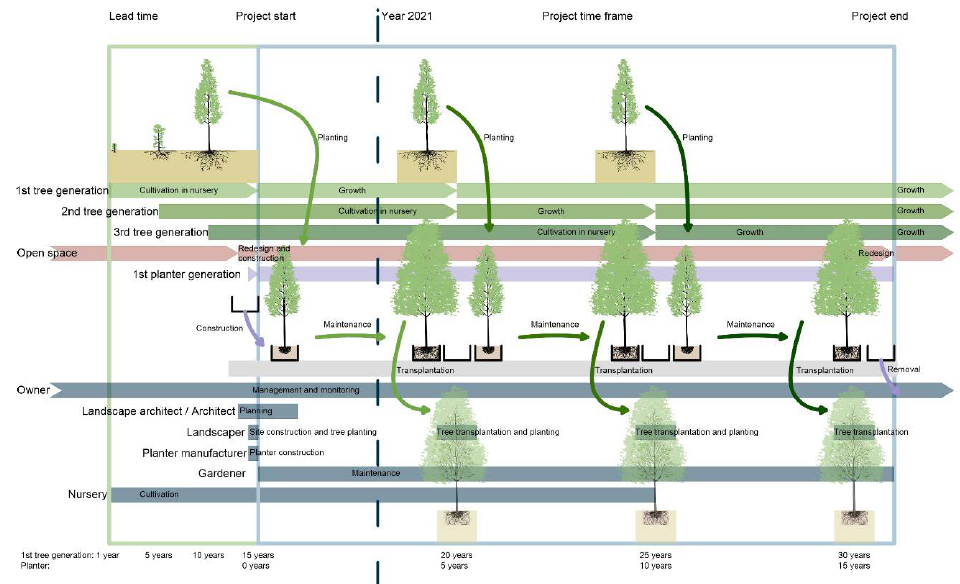
Figure 13. Time diagram of “Courtyard City Hall”.